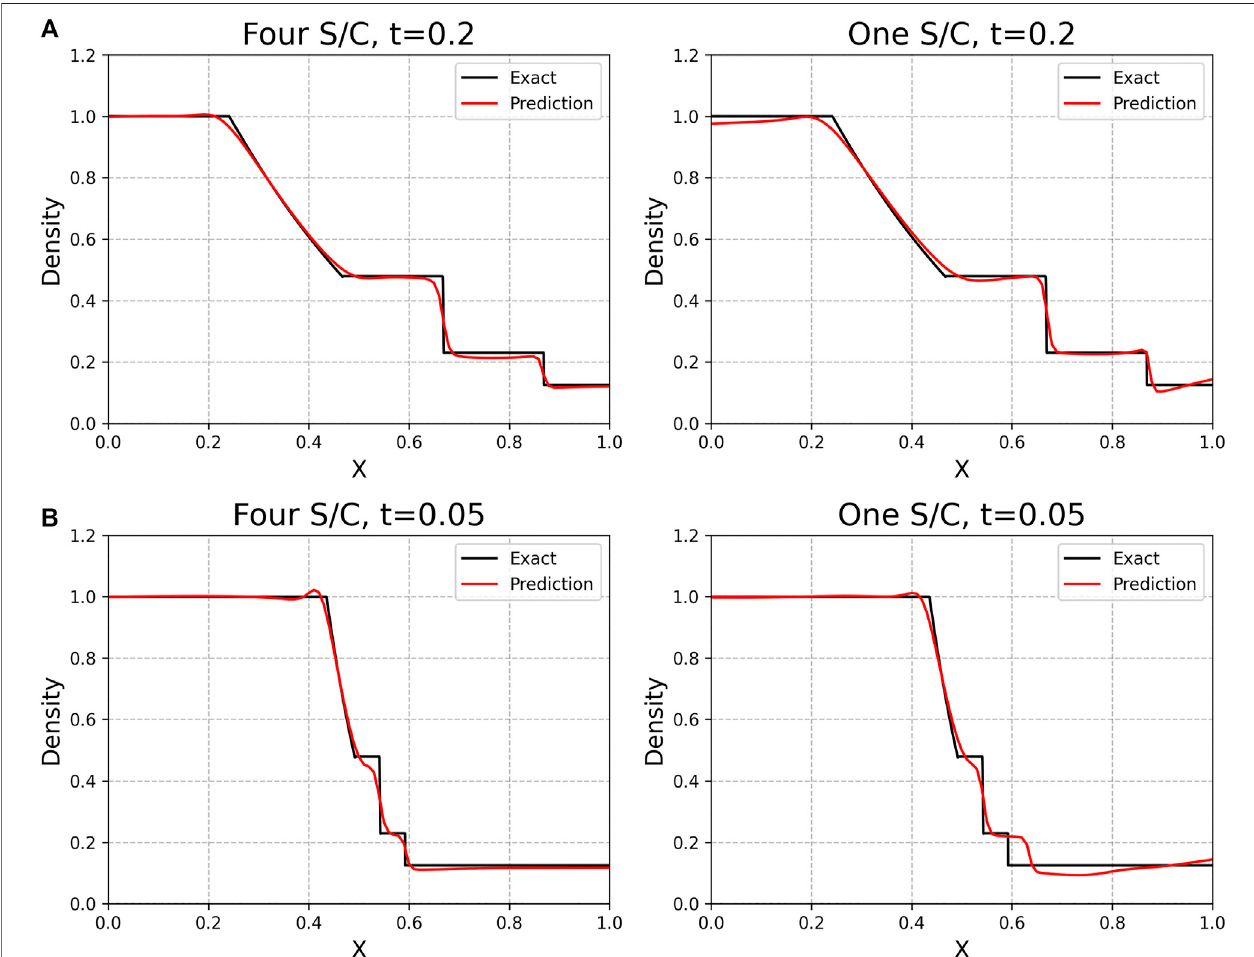
FIGURE 5 | Comparison of exact simulation values with PINN-generated predictions for ρ at t (cid:1) 0.2 (A) and t (cid:1) 0.05 (B) . The left column presents the four- spacecraftPINN fi t,whiletherightcolumnpresentstheone-spacecraftPINN fi t.ThePINNreconstructiontendstosmoothoutdiscontinuitiesandsuddengradients;this is due to adding the viscosity term (though this is still better than having no viscosity term). Additionally, the reconstruction has issues with regions further away from boundary data (lower right plot for x > 0.5; c.f. Figure 3 ).